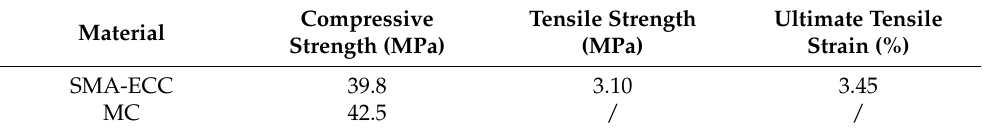
Table 1. Mechanical properties of material specimen after 28 -days of standard curing.